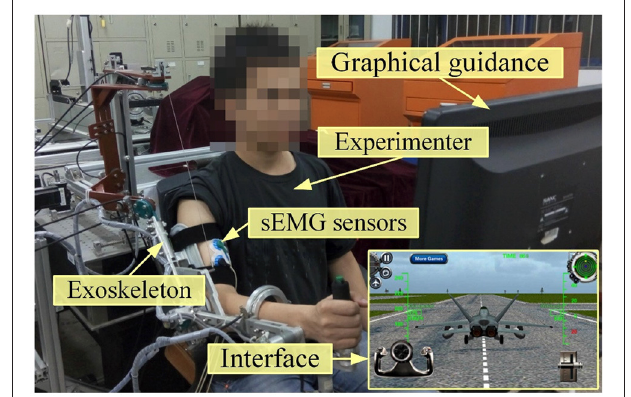
FIGURE 8 | Comparison results of RMS EMG values of bicipital muscles for different subjects and admittance parameters.